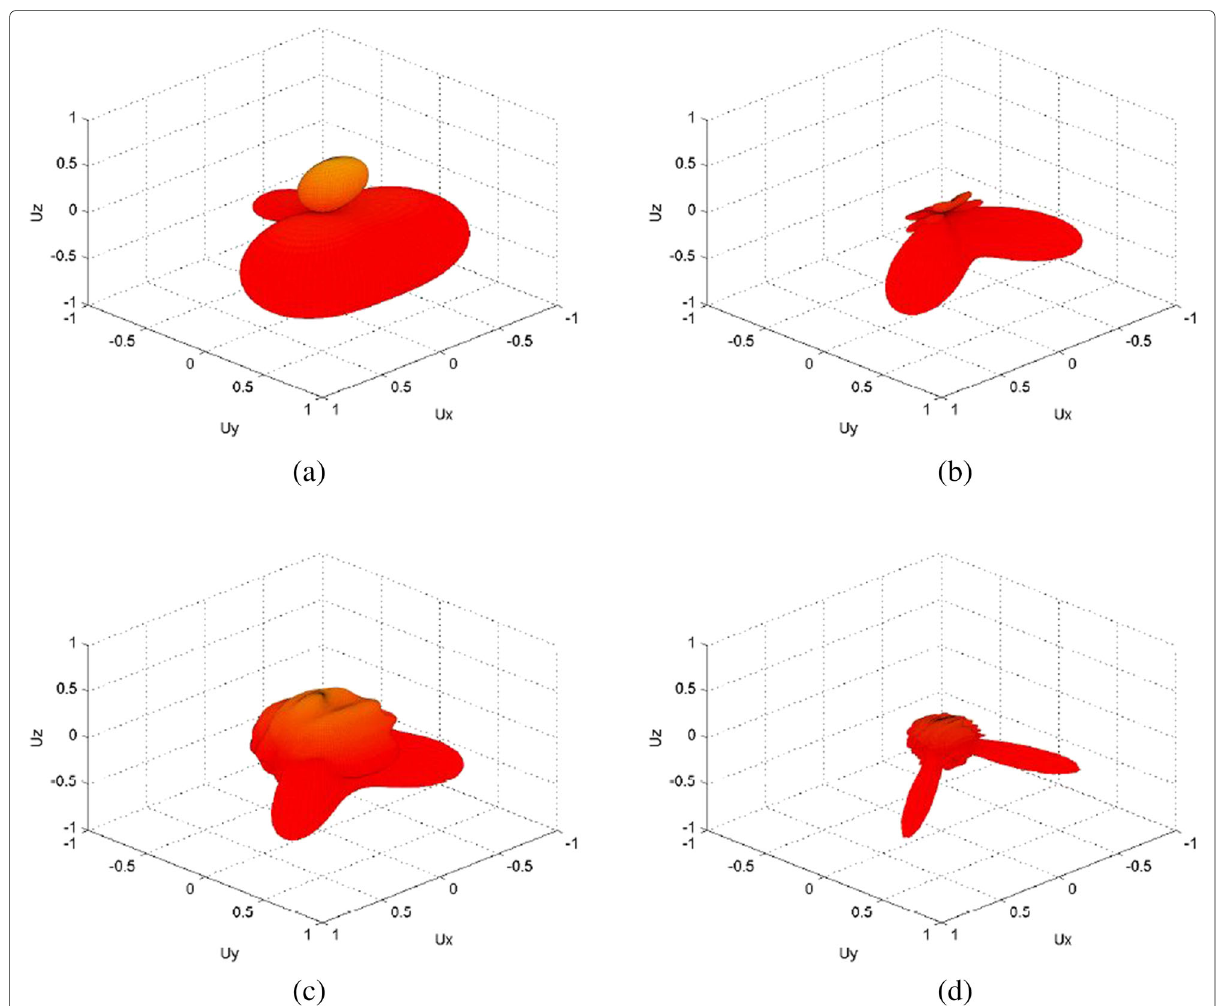
Fig. 4 The normalized beam patterns for fixed and random antenna selection with uniform planar array: a Fixed antenna selection with M = 4. b Fixed antenna selection with M = 16. c Random antenna selection with M = 4. d Random antenna selection with M =